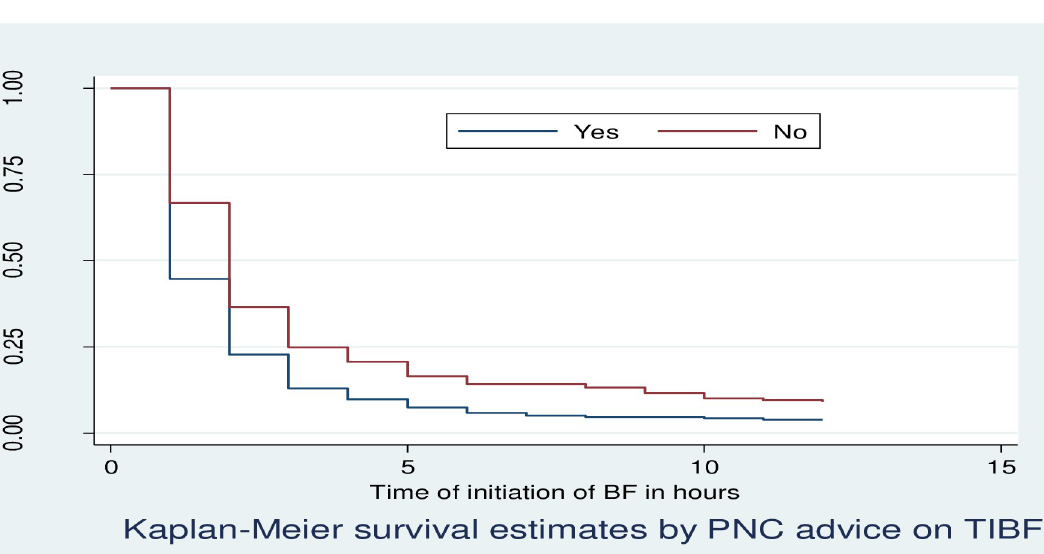
Fig 4. KM survival estimates by postnatal advice on TIBF immediately after delivery among postnatal mothers within 12 hours of giving birth in Debre Markos Comprehensive Specialized Hospital, North West, Ethiopia, 2020.